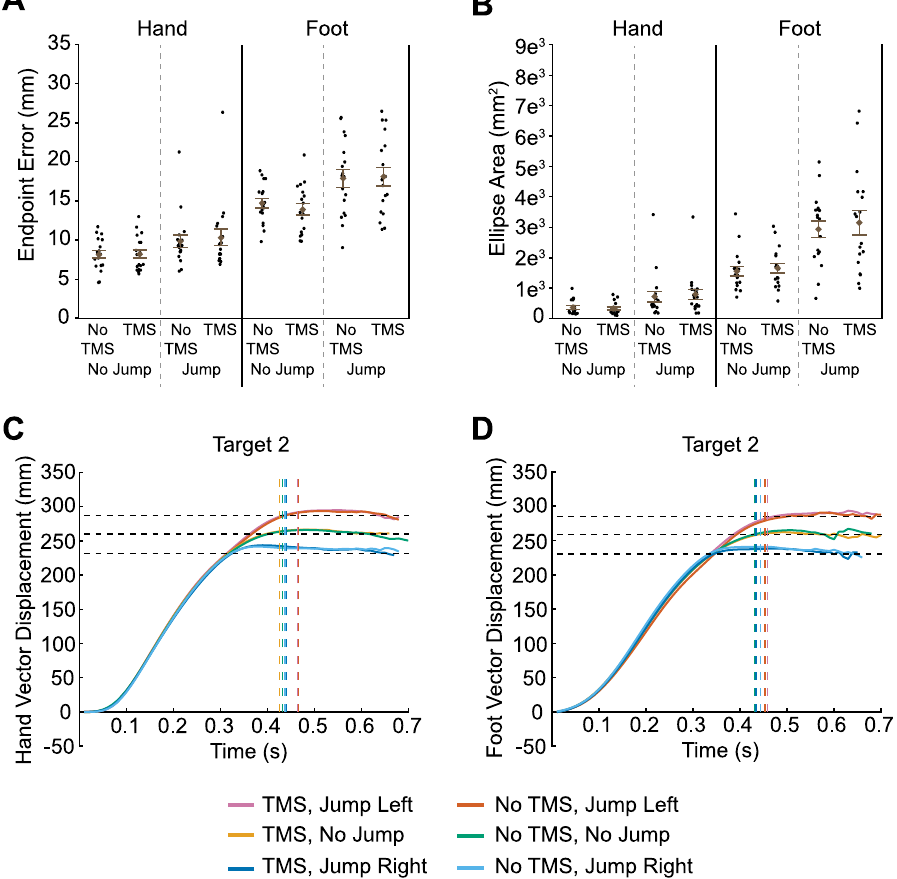
Fig 2. Results of transcranial magnetic stimulation (TMS) to IPS1. Euclidean endpoint error (A) and ellipse area based on endpoint error (B) for hand and foot reaches across all conditions. Filled circles represent mean data from each individual participant. Group mean ± SE is also shown. Hand (C) and foot (D) trajectories towards target two are shown for each condition. Horizontal dashed lines represent the final position of the target (jump left, no jump, and jump right). Vertical dashed lines indicate the average time at which the finger or toe contacted the touchscreen for each condition.